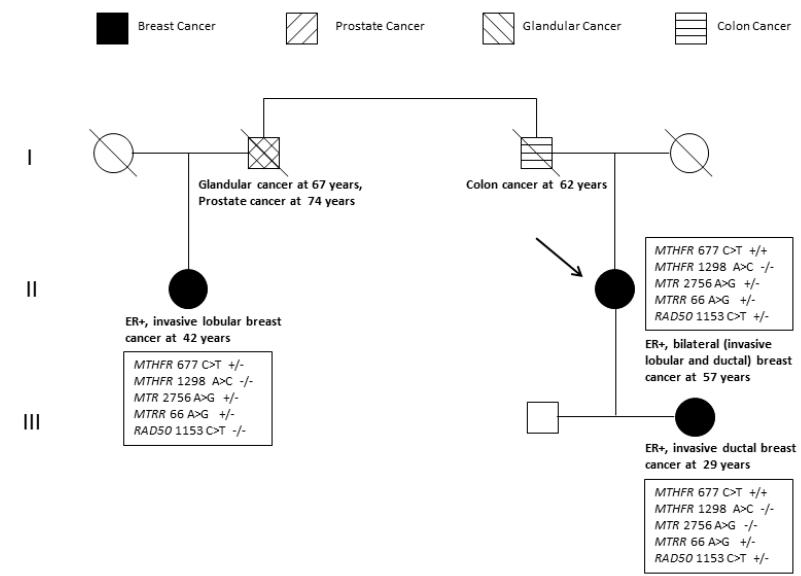
Figure 4. Pedigree of the index patient (arrow) subjected to whole exome sequencing, depicting the clinical (age of onset), pathology (tumour characteristics) and genetic heterogeneity in the family. Homozygosity for a minor allele is indicated by (+/+) and heterozygosity by (+/ − ). ER+: estrogen receptor-positive.